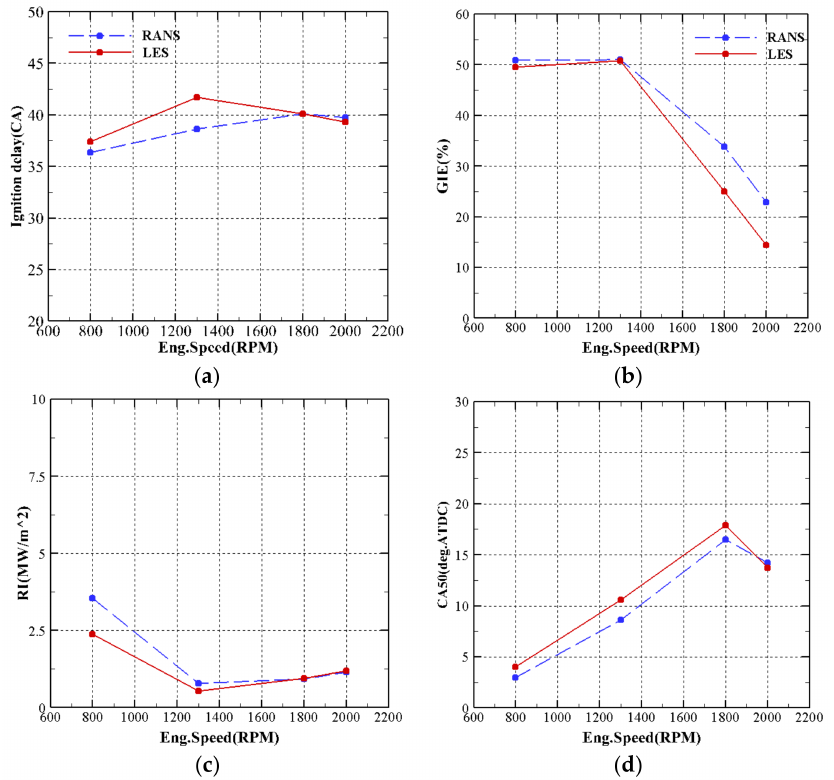
Figure 13. Effect of engine speed sweep on: ( a ) ID, ( b ) GIE, ( c ) RI and ( d ) CA50 for LES and RANS model.